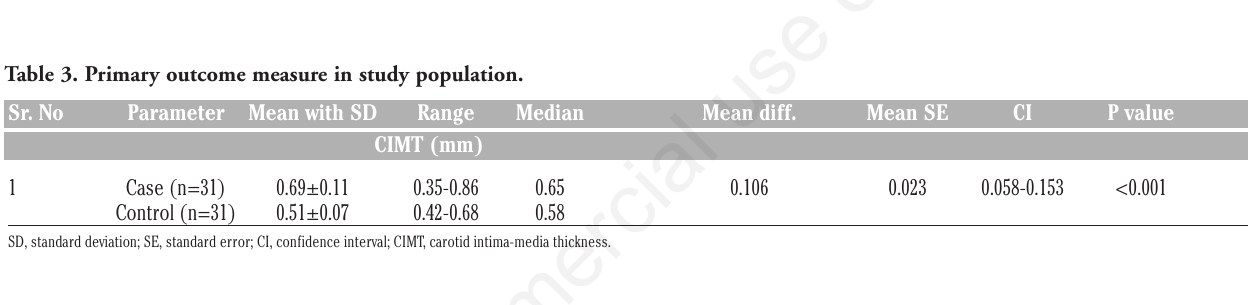
Table 4. Secondary outcome measures in study population.